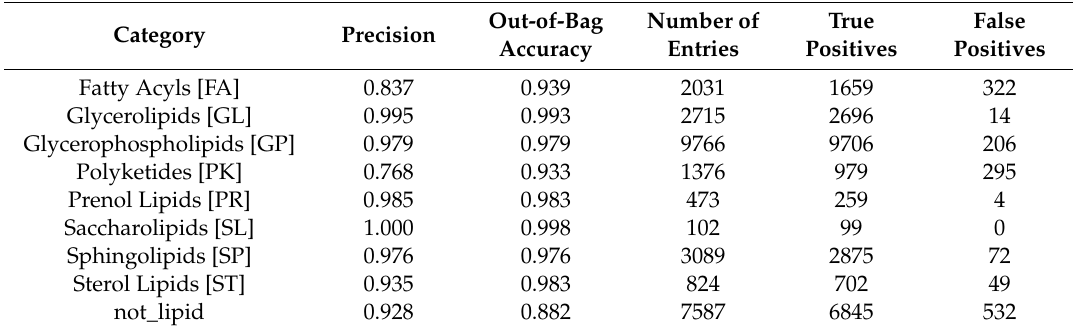
Table 2. LMSD + LIPIDMAPS In-Silico Structure Database (LMISSD) + HMDB_non_lipid model performance